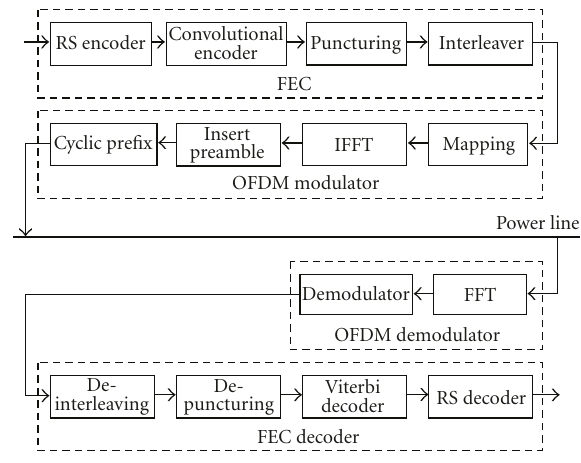
Figure 1: The HomePlug 1.0 Standard